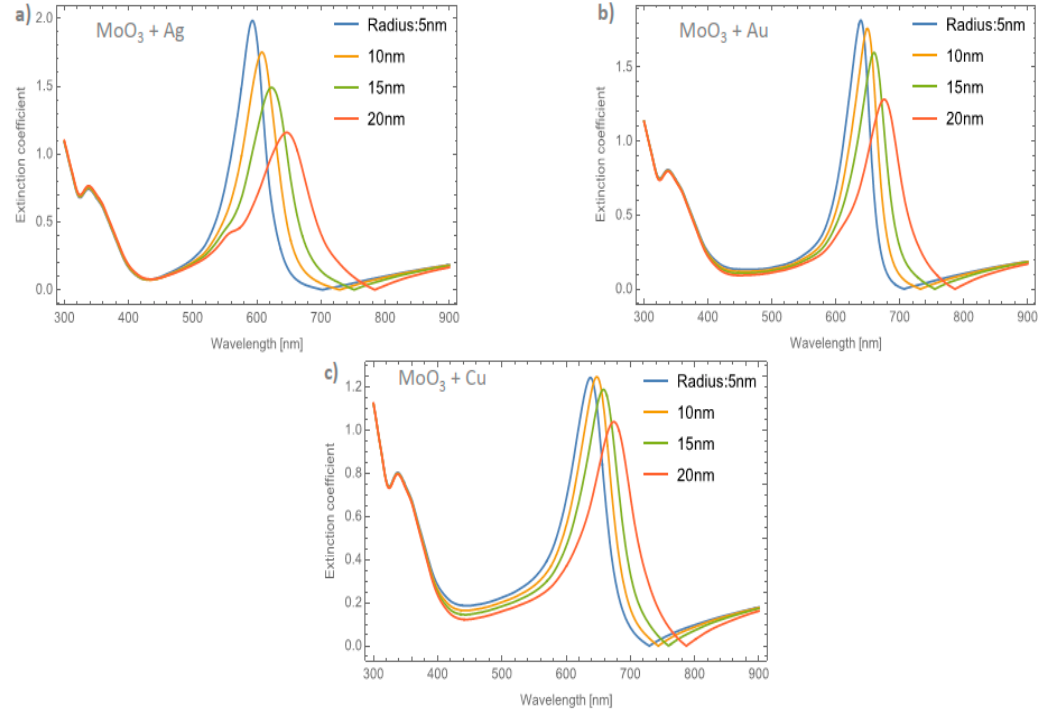
Figure 9. The extinction coefficient of the MoO 3 thin film doped with ( a ) Ag-NPs, ( b ) Au-NPs, and ( c ) Cu-NPs for a volume filling fraction of 5%. In all spectra, the thickness was fixed to a value of 120 nm, and different NPs radii are labeled.